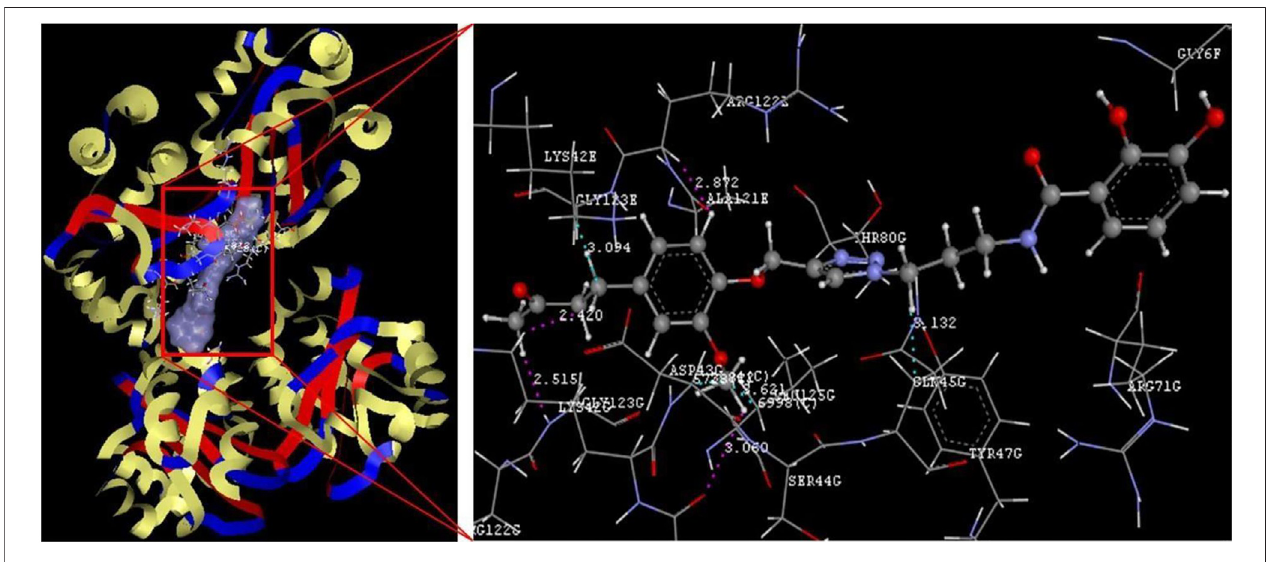
FIGURE 2 | Conjugate 1 binding with the 2UV0